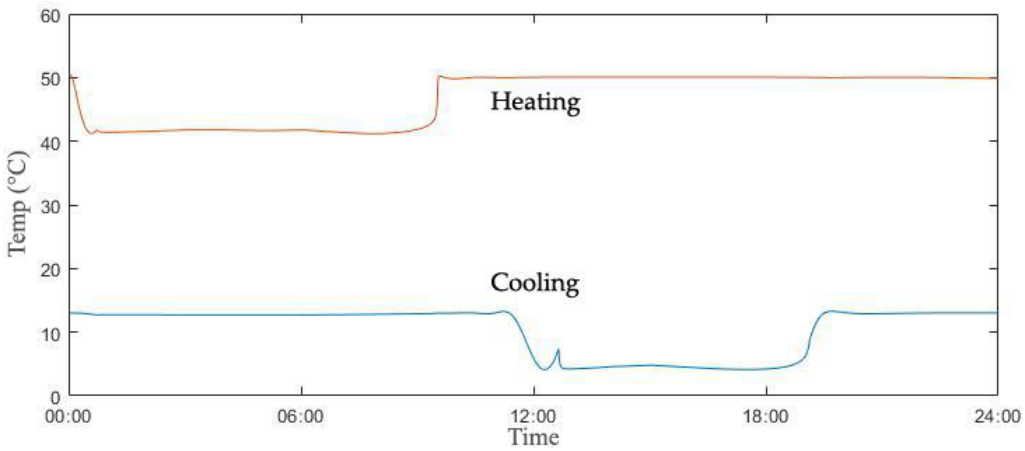
Figure 12. Signals for the temperature of supply air by the ANN control.